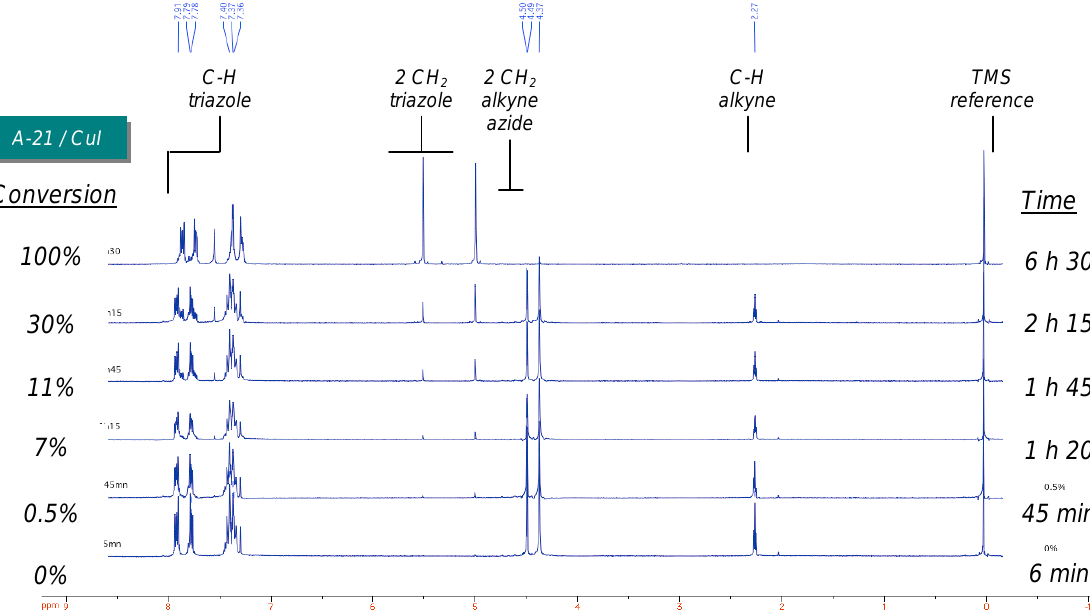
containing 10 mol % of the catalyst 0.5 mmol alkyne 3